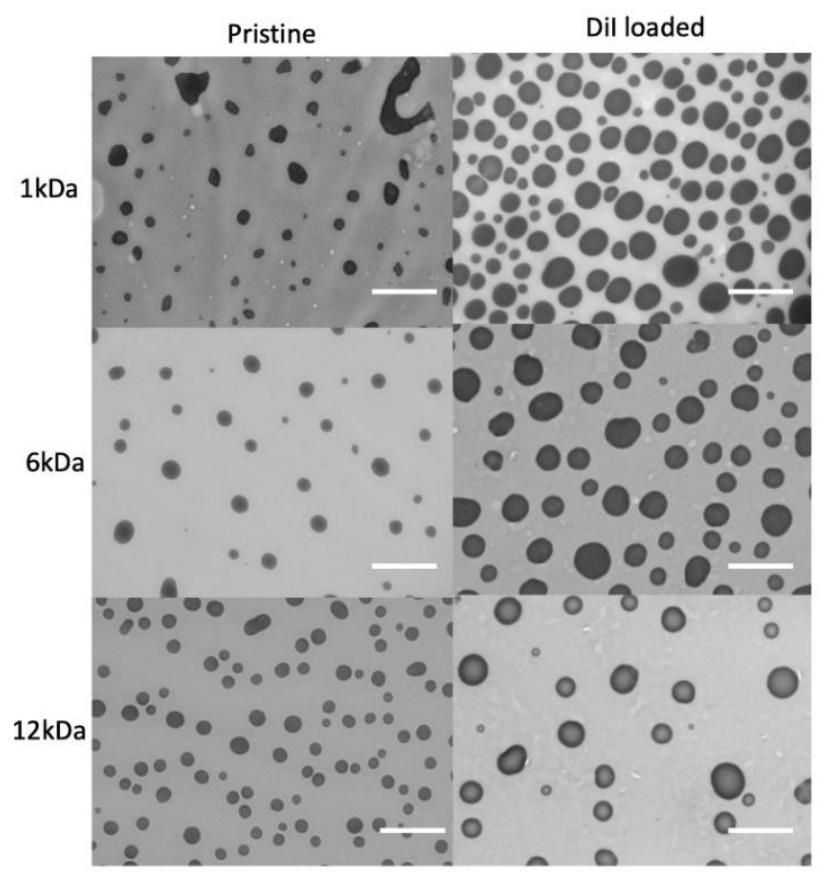
Figure 4. TEM micrographs of PVP-OD nanoaggregates formed by molecules with a different molecular weight of the hydrophilic part (1 kDa, 6 kDa, and 12 kDa) before and after DiI loading. Scale bars are 1 µm.